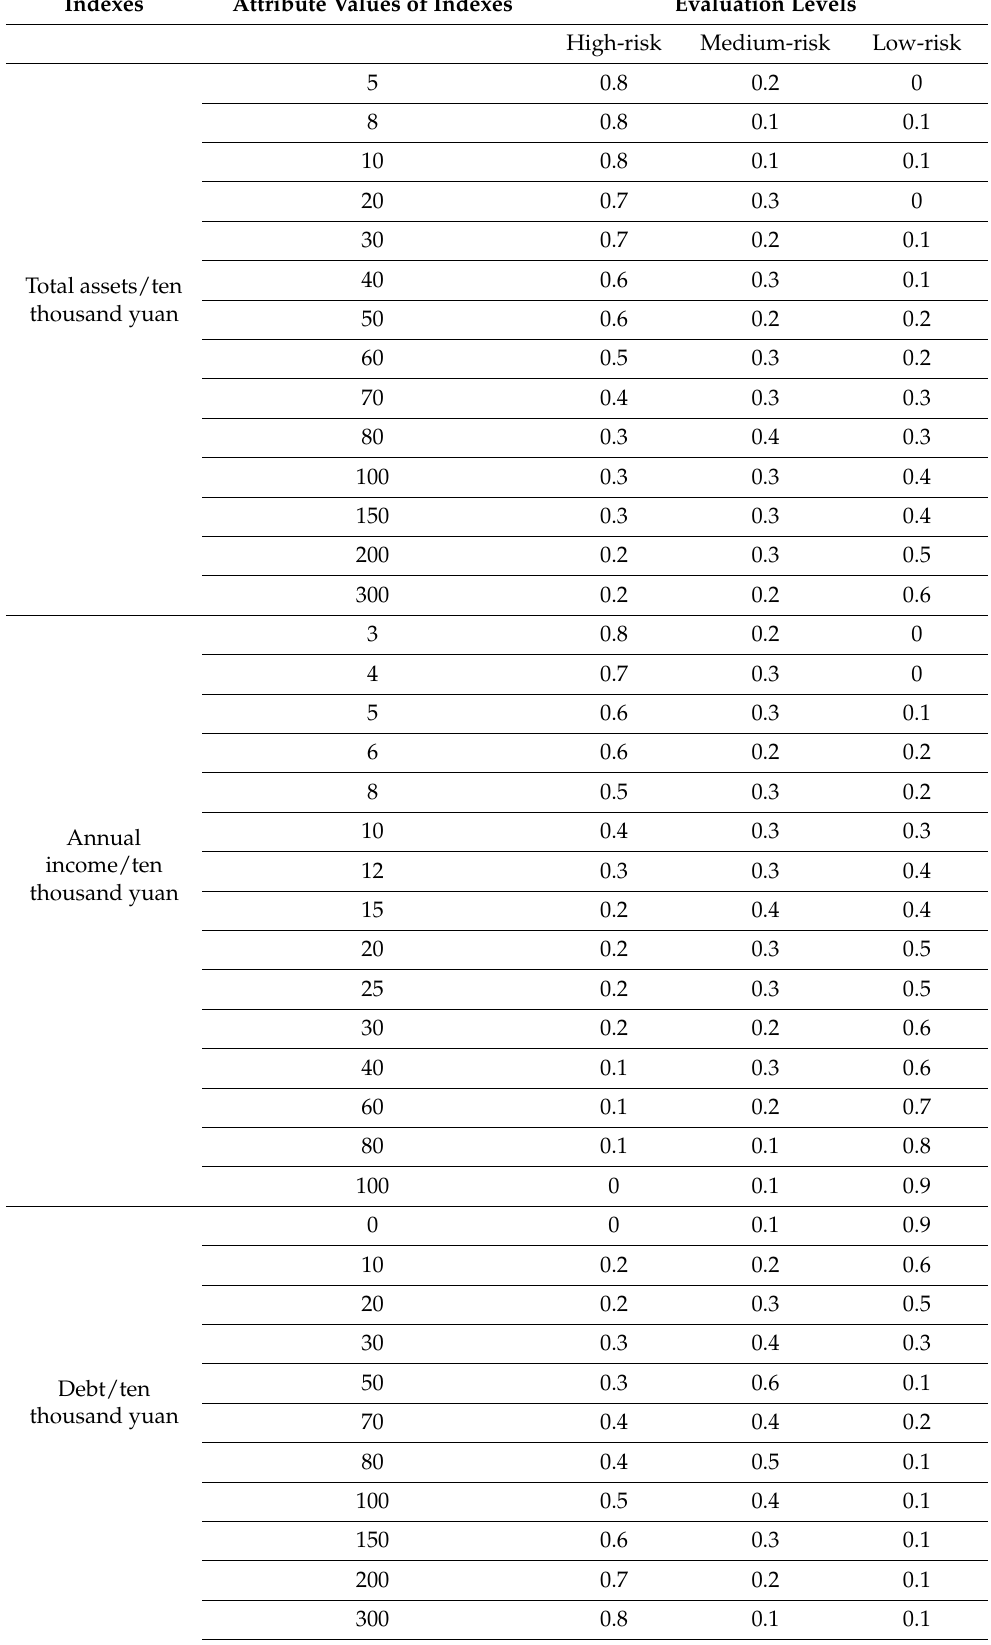
Table A14. Single factor evaluation of economic situation